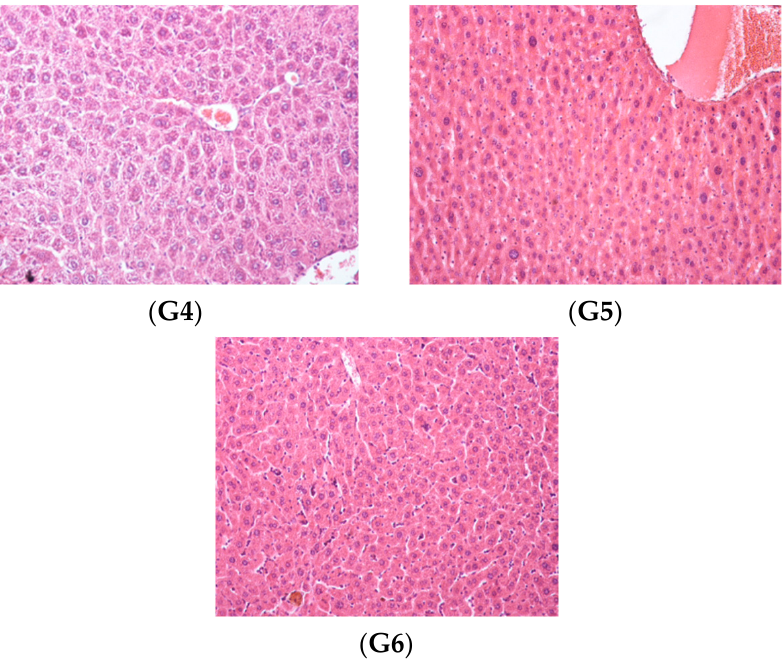
Figure 8. Liver, hematoxylin and eosin staining × 20: Group 1, ( G1. A ) sinusoidal dilatations, capillary mononuclear cell infiltrations and the onset of necrosis and ( G1. B ) small areas of perivascular inflammation; Group 2, ( G2. A ) areas of vascular congestion and ( G2. B ) sinusoidal dilatations and reduced areas of inflammation; Group 3, ( G3. A ) extensive vascular congestion and ( G3. B ) slight sinusoidal dilatations; Group 4 ( G4 ), hepatocellular vacuolation and reduced vascular congestion; Group 5 ( G5 ), normal liver morphology; Group 6 ( G6 ), normal liver morphology.